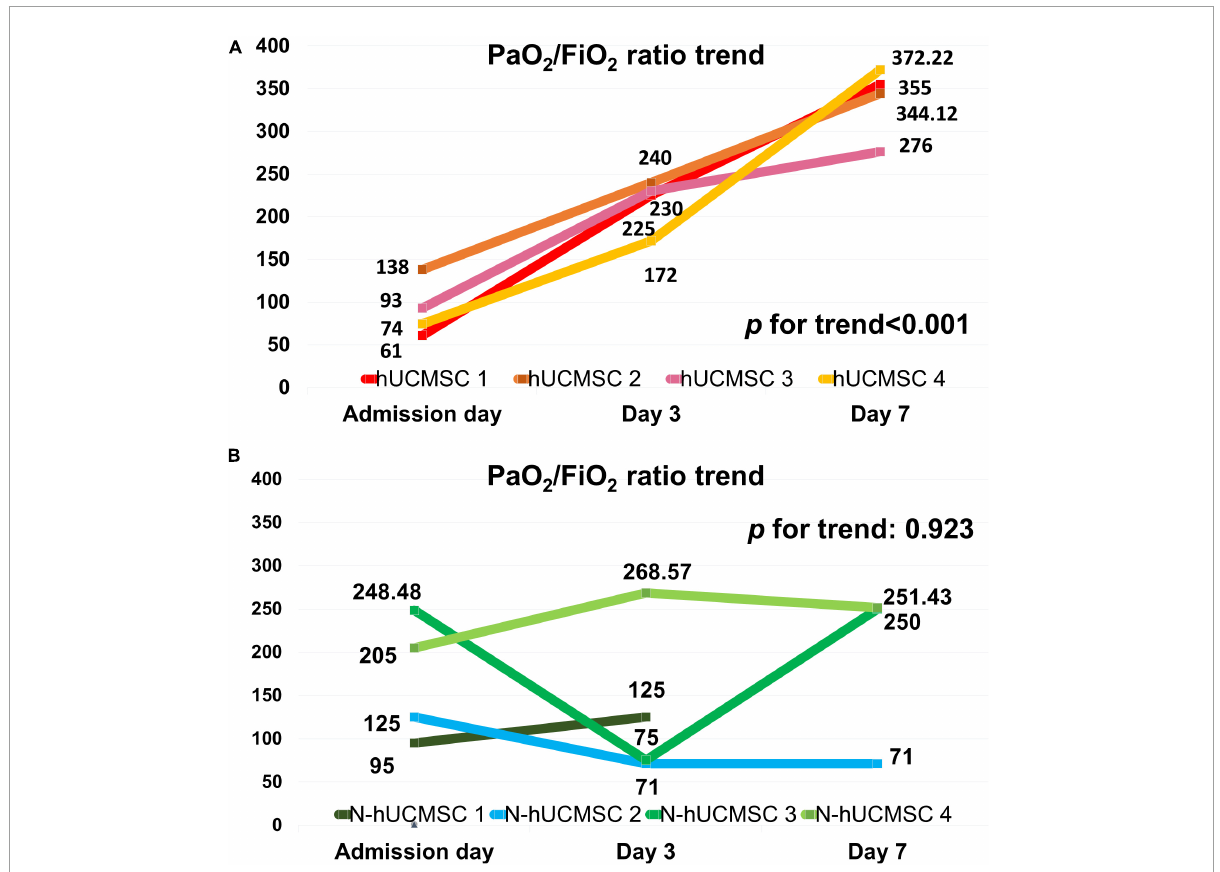
FIGURE3 PaO 2 /FiO 2 ratio trends on hUC-MSC and non-hUC-MSC patients. (A) PaO 2 /FiO 2 ratio trend on hUC-MSC patients. In hUC-MSC group, data on the day of admission, post-hUC-MSC day 3, and day 7 were recorded. (B) PaO 2 /FiO 2 ratio trend on non-hUC-MSC patients. In the non-hUC-MSC group, the PaO 2 /FiO 2 ratio on the day of admission, day 3, and day 7 of hospitalization are listed. In non-hUC-MSC case 1, no further arterial gas examination needed on day 7 was judged by the primary care physician because of obvious clinical improvements in this patient. Abbreviations as in Figure 2 .